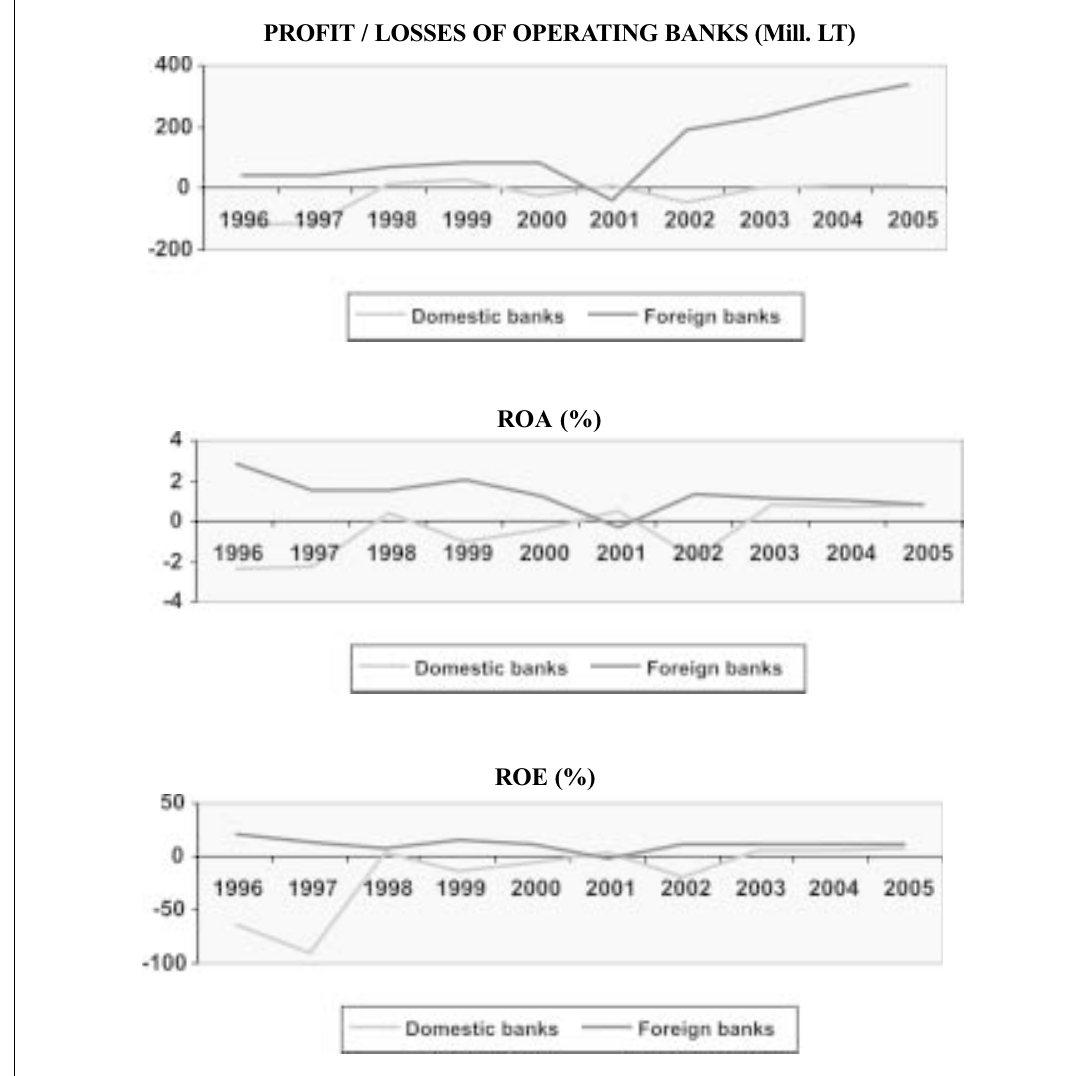
Fig 5 . Performance of Lithuanian banking sector. Source of initial data: Lithuanian